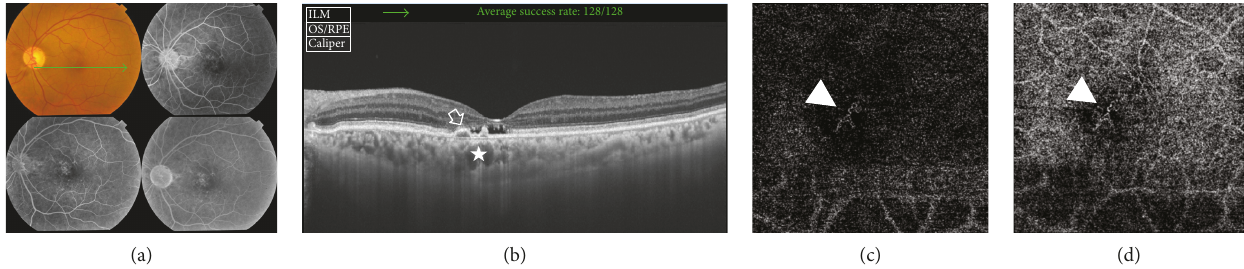
Figure 3: (a) The colored photo and FFA of the left eye of a 40-year-old male with left chronic CSCR of approximately 1-year duration. The posterior pole shows retinal pigment epitheliopathy in the macular area. FFA of the same eye shows multiple hyper fl uorescent leaking points in the macular area that gradually increase in intensity throughout later phases resulting in a di ff use ill-de fi ned hyper fl uorescence pattern. (b) The corresponding SS-OCT image in a radial scan mode shows subfoveal shallow neurosensory detachment with subretinal deposits and associated disruption of ELM and IS/OS layers. Note the double-humped irregular PED in the parafoveal area with underlying opaque hyperre fl ective material (open arrow). The choroid vessels underneath the PED are engorged (star). Subfoveal choroidal thickness is 315 μ . (c) The en face SS-OCTA image of the same eye taken at the level of the outer retina in a 6 mm × 6mm fi eld. Note the hyperintense signal caused by increased blood fl ow within the CNV complex composed of tiny intertwining vascular loops (arrow head). (d) The en face SS-OCTA image of the same lesion at the level of the